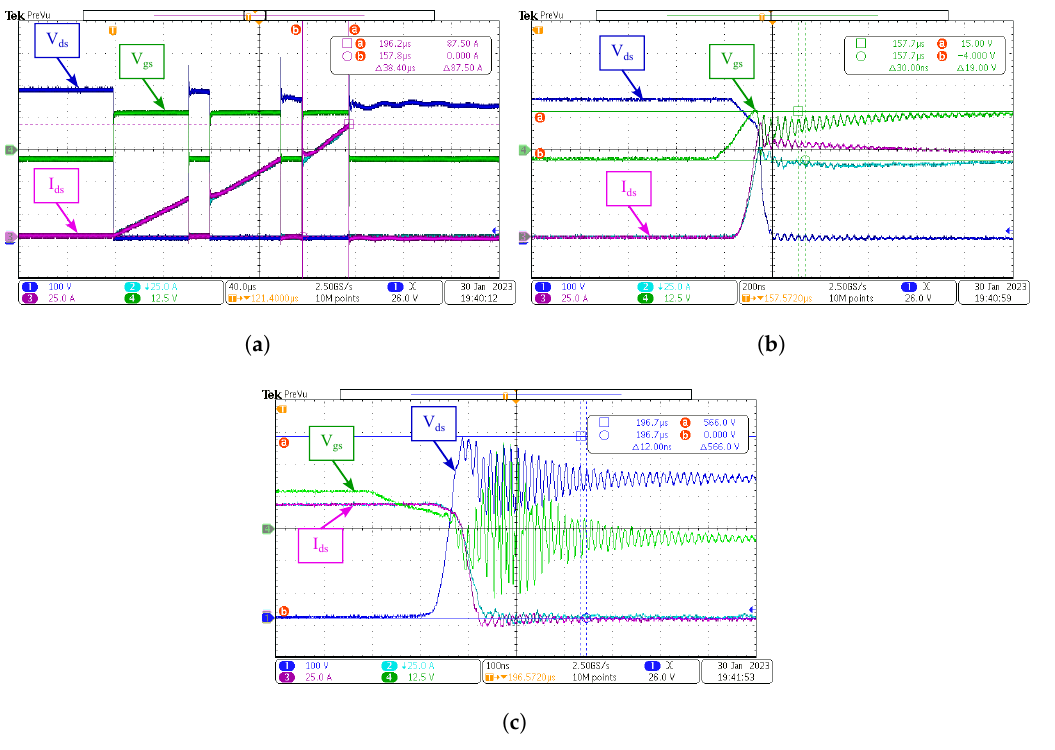
link voltage case, ( a ) Triple pulse test waveform, ( b ) Gate − source voltage −